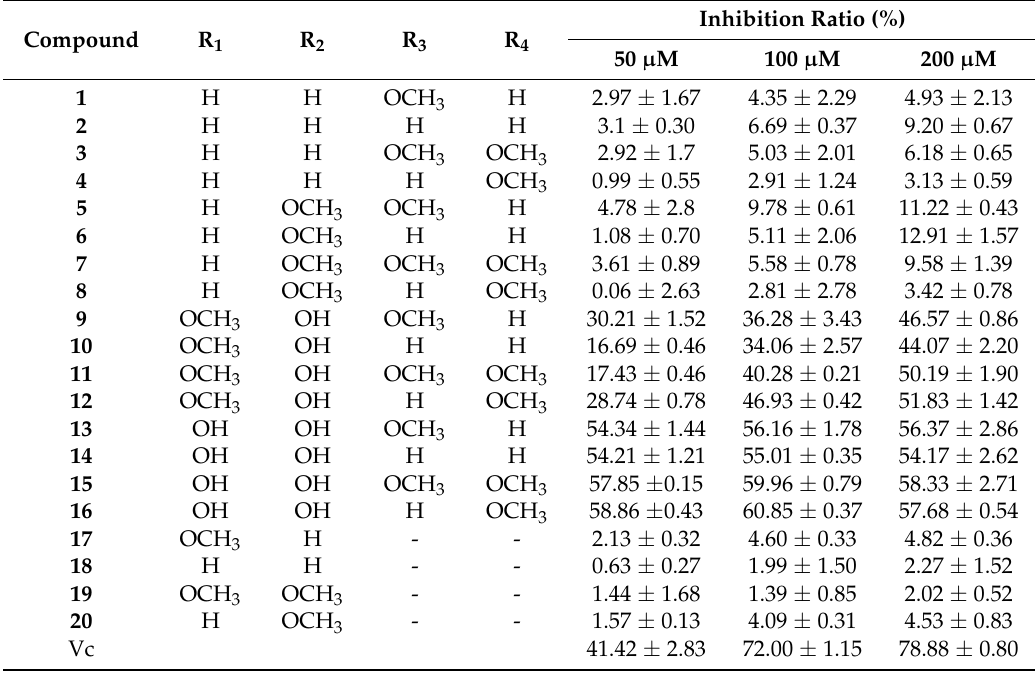
Table 1. The DPPH assay result for compounds 1 – 20 .